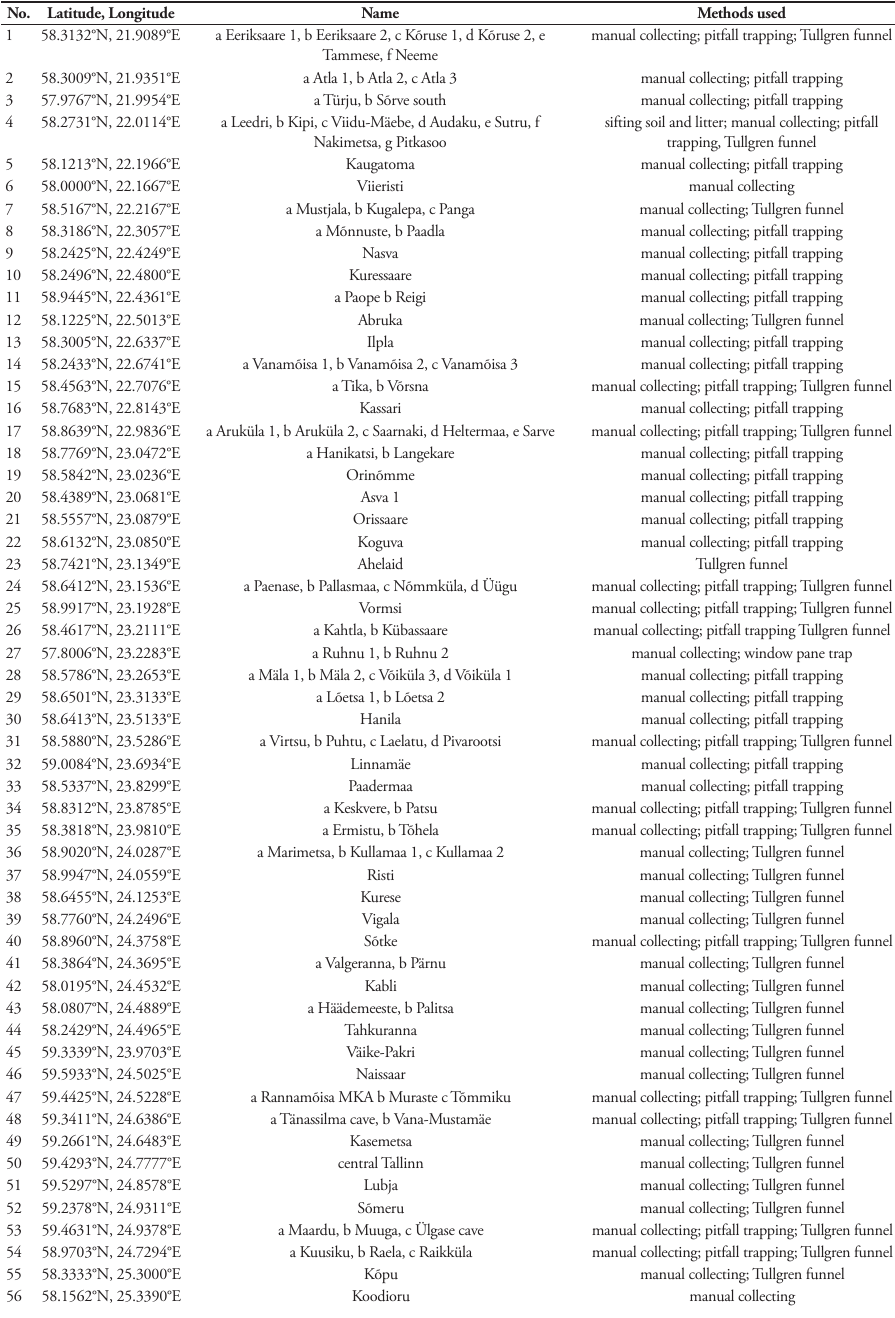
Table 1. Collecting localities of Estonian Oniscidea. The localities’ numbers correspond to those on Figure 1. Localities within a range of less than 10 km are presented by one number, the different place names (sub-lo- calities) under one number are designated consecutive letters (the coordinates apply only to the first of